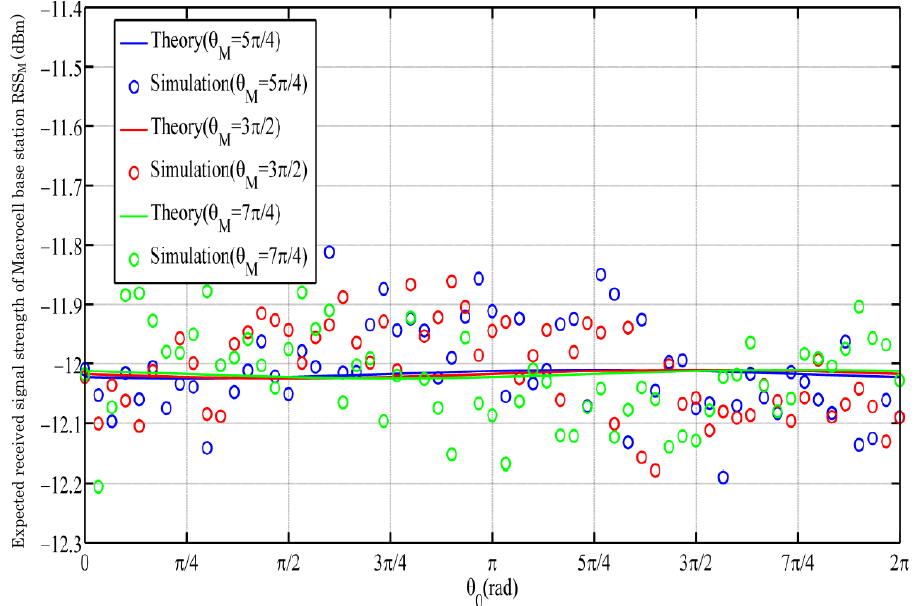
Figure 7. When r = 2 m/s, expected received signal strength of macrocell base station RSS M .